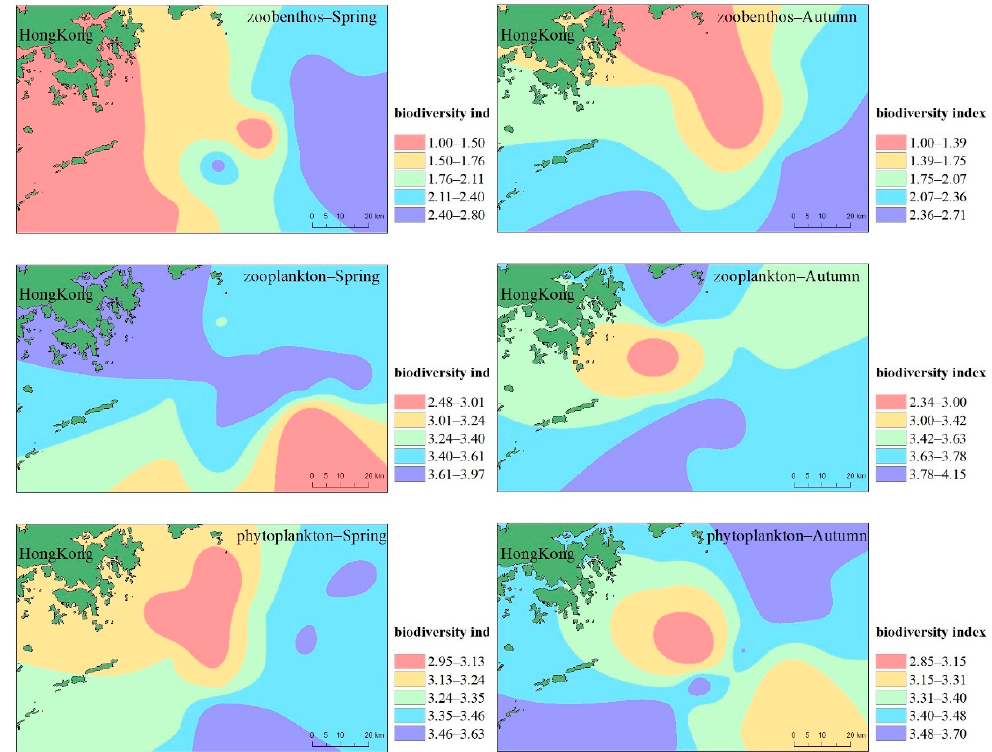
Figure 5. Evaluation results of species diversity index in coast of Hong Kong.